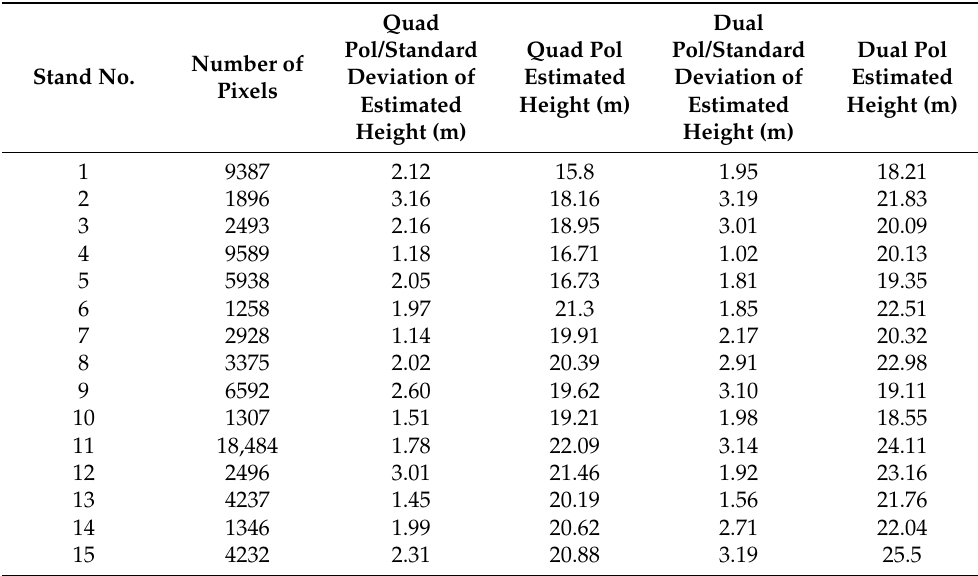
Table 3. The number of pixels of each stand and the standard deviations of the estimated forest heights based on the proposed